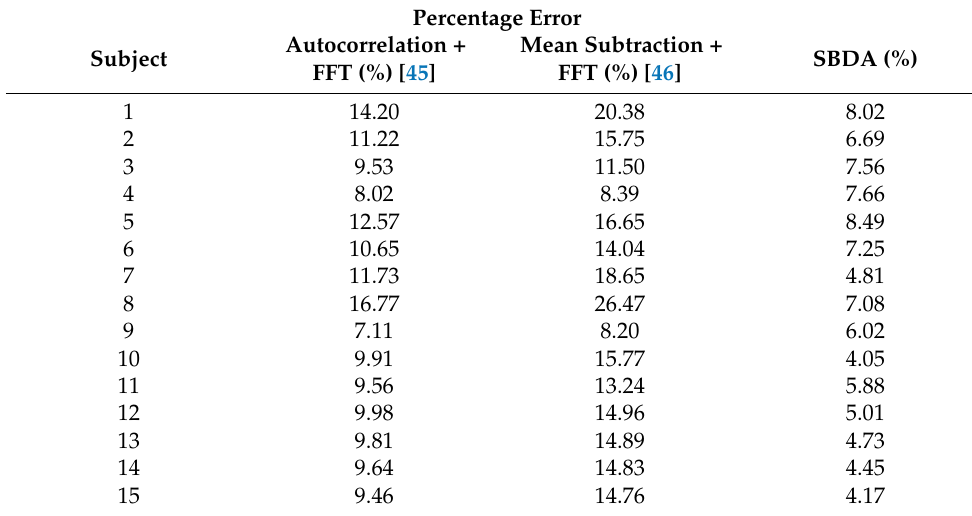
Table 3. Summary of percentage